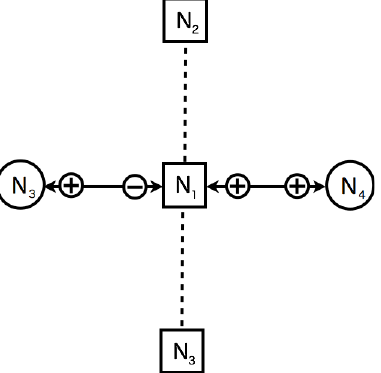
Figure 8. An illustrative example of a constraint on virtual sensors in the dynamic relational network. The circles and squares indicate the real and virtual sensor nodes respectively. The sensor nodes colored white is normal. The solid lines indicate diagnosis flow of mutual diagnosis. The dashed line indicate diagnosis flow from real sensors to virtual sensors. The plus (minus) indicate the diagnosis result as normal (abnormal) from the source node to the target